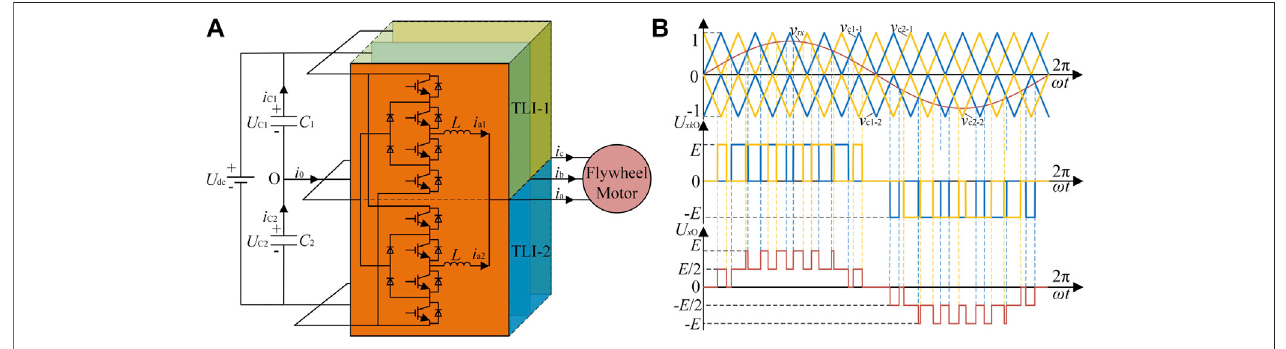
FIGURE 1 | Topology and modulation of the parallel system: (A) topology, (B) interleaved parallel